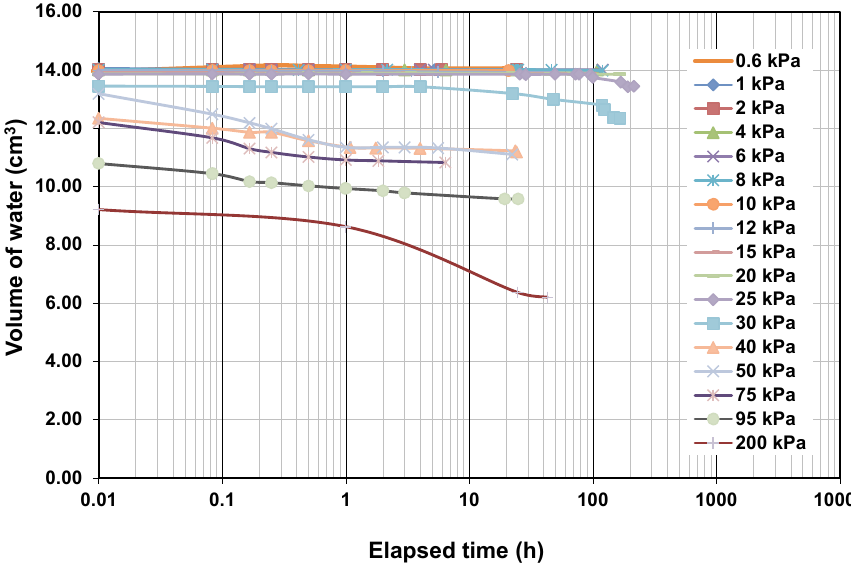
Figure 4. Equalization time of soil specimen 70S30K.